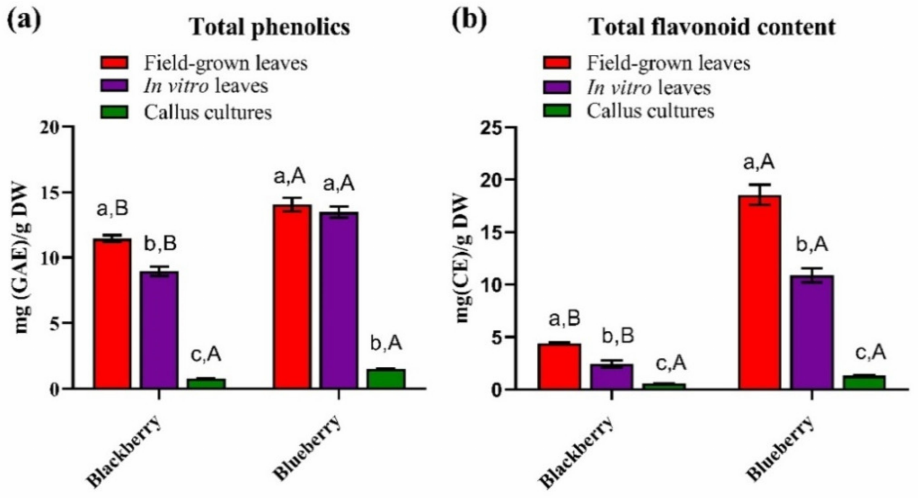
Figure 2. ( a ) Total phenolic content and ( b ) Total flavonoid content of blackberry ‘ ˇCaˇcanska Bestrna’ and blueberry ‘Toro’ leaves and callus samples. The bars with ( ± ) standard deviation represent mean values. The different lowercase letters indicate a significant difference ( p < 0.05) between field-grown leaves, in vitro leaves and callus culture of the same berry; different uppercase letters indicate a significant difference ( p < 0.05) between the same type of samples of two different berry cultivars. The TPC of aqueous extracts of field-grown and in vitro leaves of ‘Toro’ blueberry were 14.06 ± 0.51 and 13.47 ± 0.42 mg GAE/g DW, without a statistically significant difference ( p < 0.05). These values are significantly lower (almost 10-fold lower) than the TPC values for field-grown leaves of six cultivated blueberry cultivars, including ‘Toro’ (132.92 mg GAE/g leaves material), reported by S tef ă nescu et al. [6]. In addition, Wu , et al. [11] also reported significantly higher TPC values for blueberry field-grown leaves from 73 different cultivars collected in southern China, which ranged from 32.18 ± 0.01 (‘O’Neal’) to 224.1 ± 3.4 (‘Blackpearl’) mg GAE/g DW. Moreover, the same study deter- mined TPC values in the leaves of field-grown ‘Toro’ plants of 75.07 ± 1.48 mg